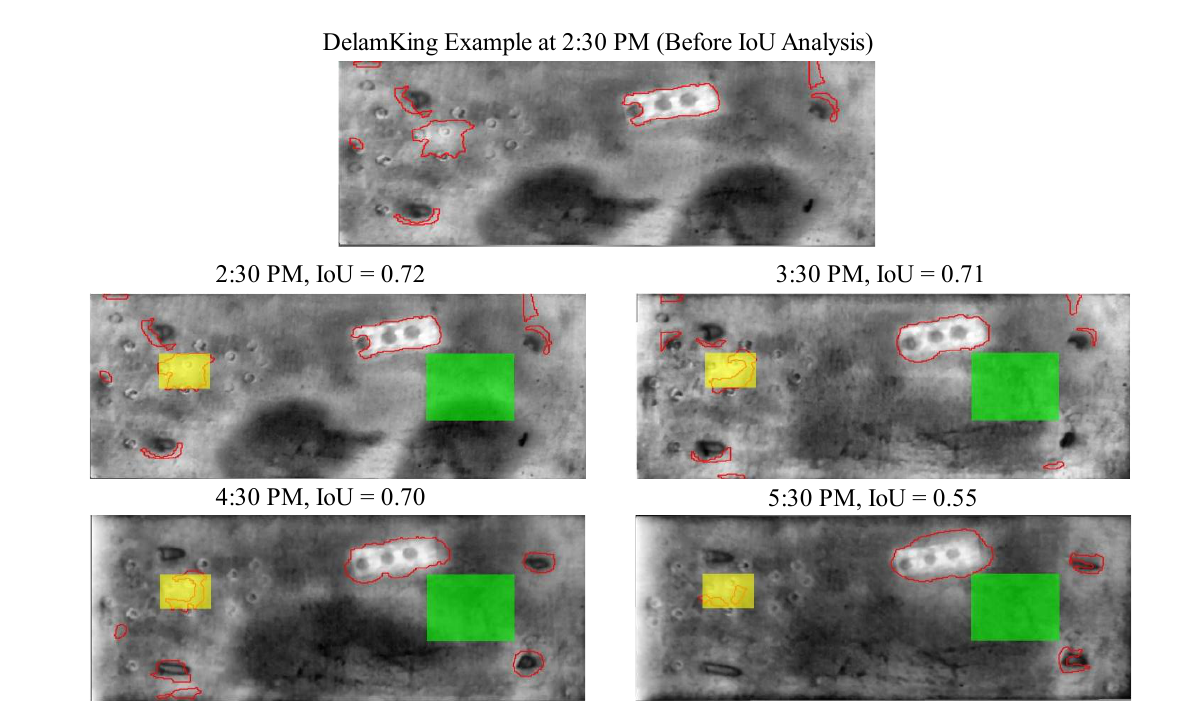
Figure 11. IoU analysis IRT results of data collected on the 24th of June 2021.